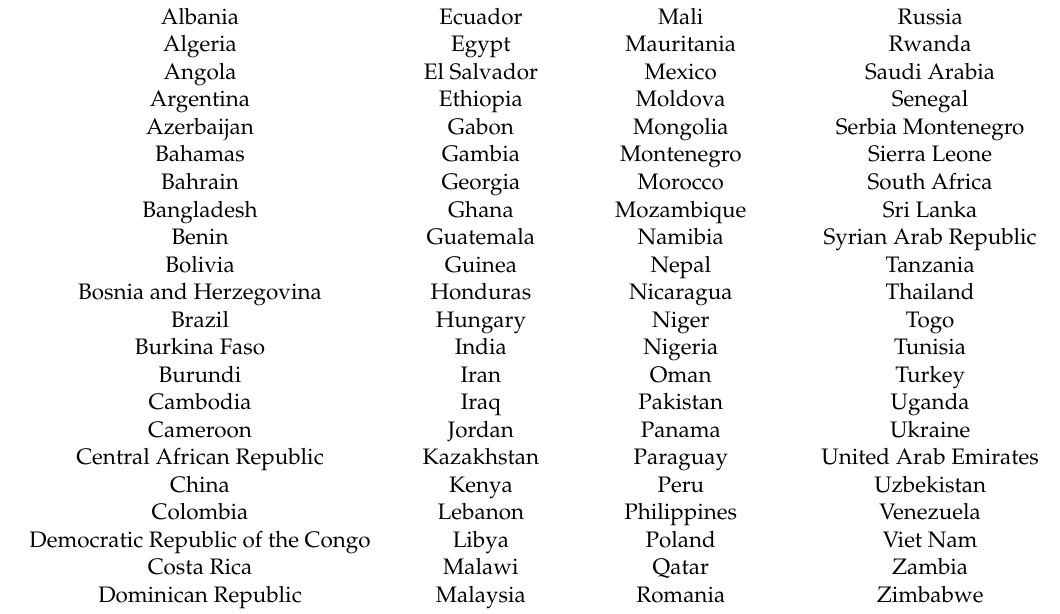
Table A1. List of developing and emerging economies.